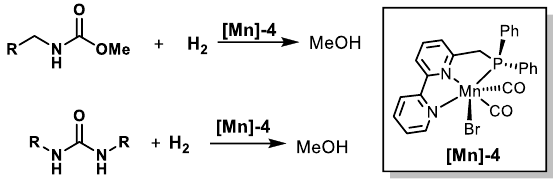
Figure 16. Mn-catalyzed hydrogenation of carbamates and ureas.